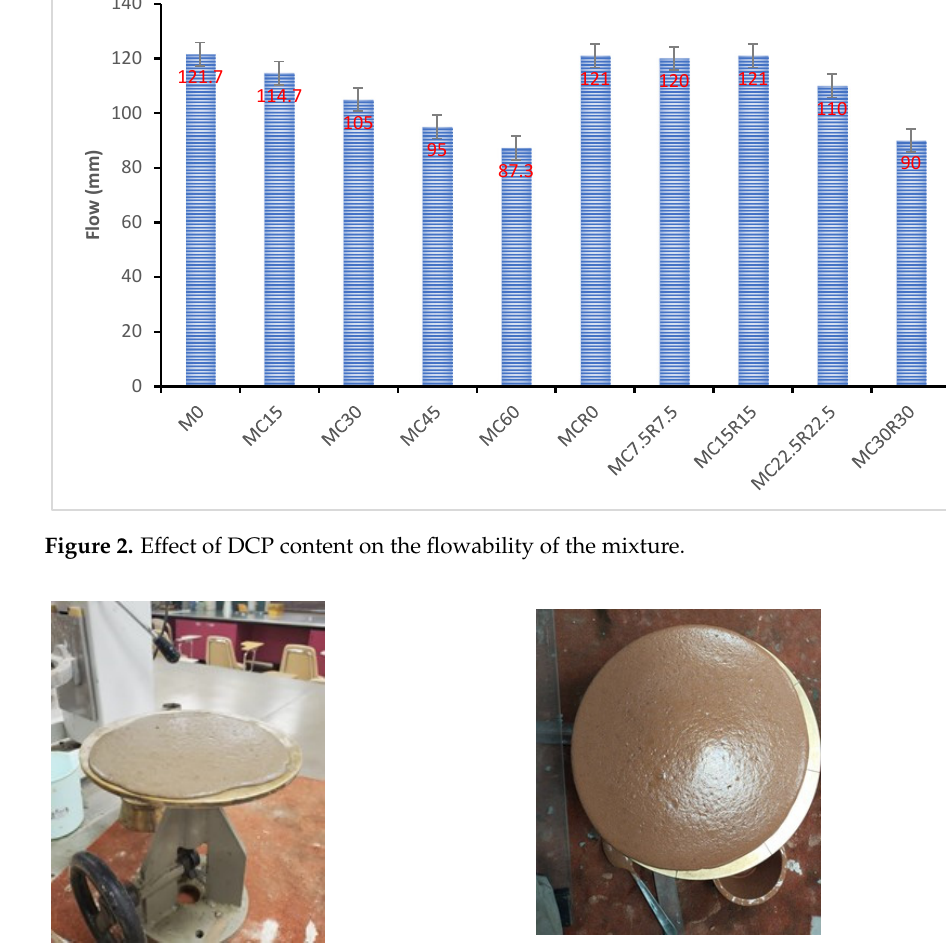
Figure 3. Test setup of flowability of GBFS with: ( a ) DCP; ( b ) DCP + RM.